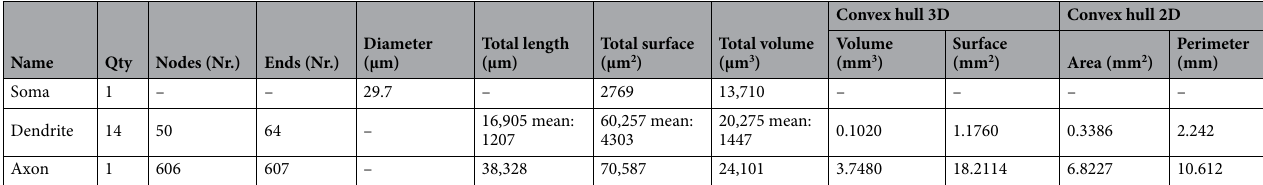
Table 1. Basic morphological parameters of L6SC. Note that data are corrected for tissue shrinkage. Convex Hull analysis measures the size of the dendritic/axonal field by interpreting the branched structure as a solid object, i.e. a convex polygon is generated by connecting the tips of the distal dendritic/axonal branches. For the 2D analysis, the L6SC was viewed in the tangential plane (parallel to the pial surface).